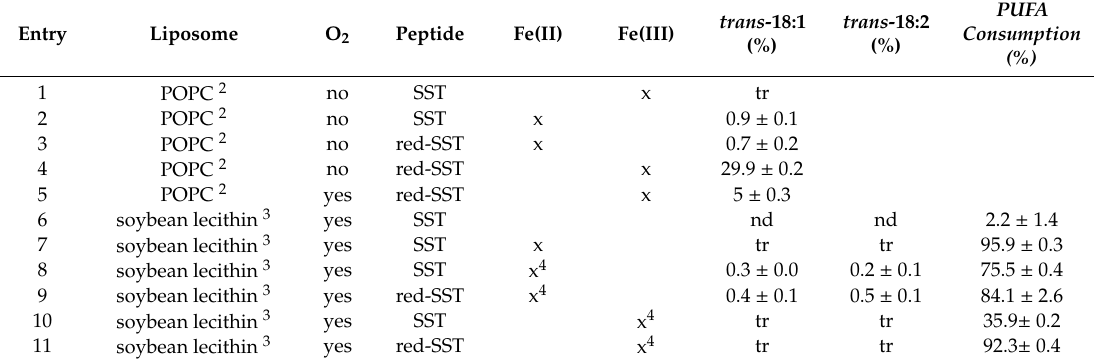
Nd = not detectable; tr = traces (<0.1%) 1 The fatty acid residues were obtained from the liposome suspension after lipid extraction and transesterification, as described in the Materials and Methods. 2